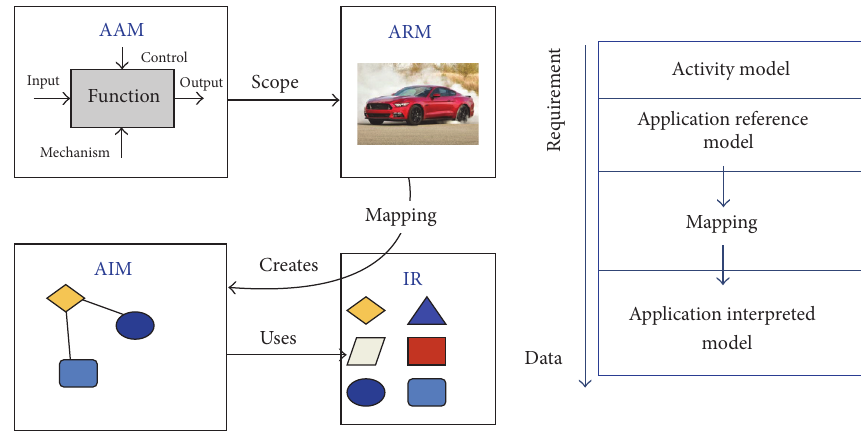
Figure 1: STEP standard